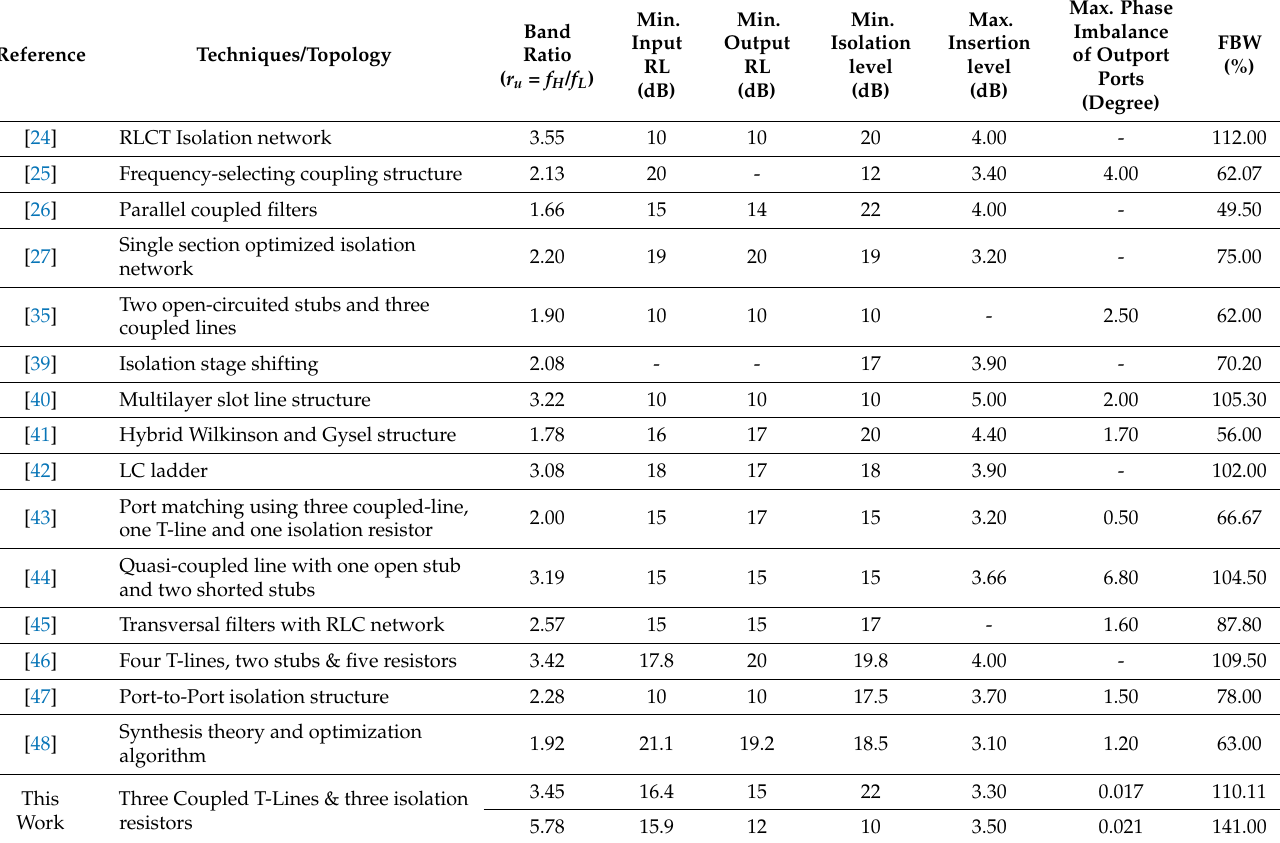
Table 5. Comparison of performance among this WPD and some other recent